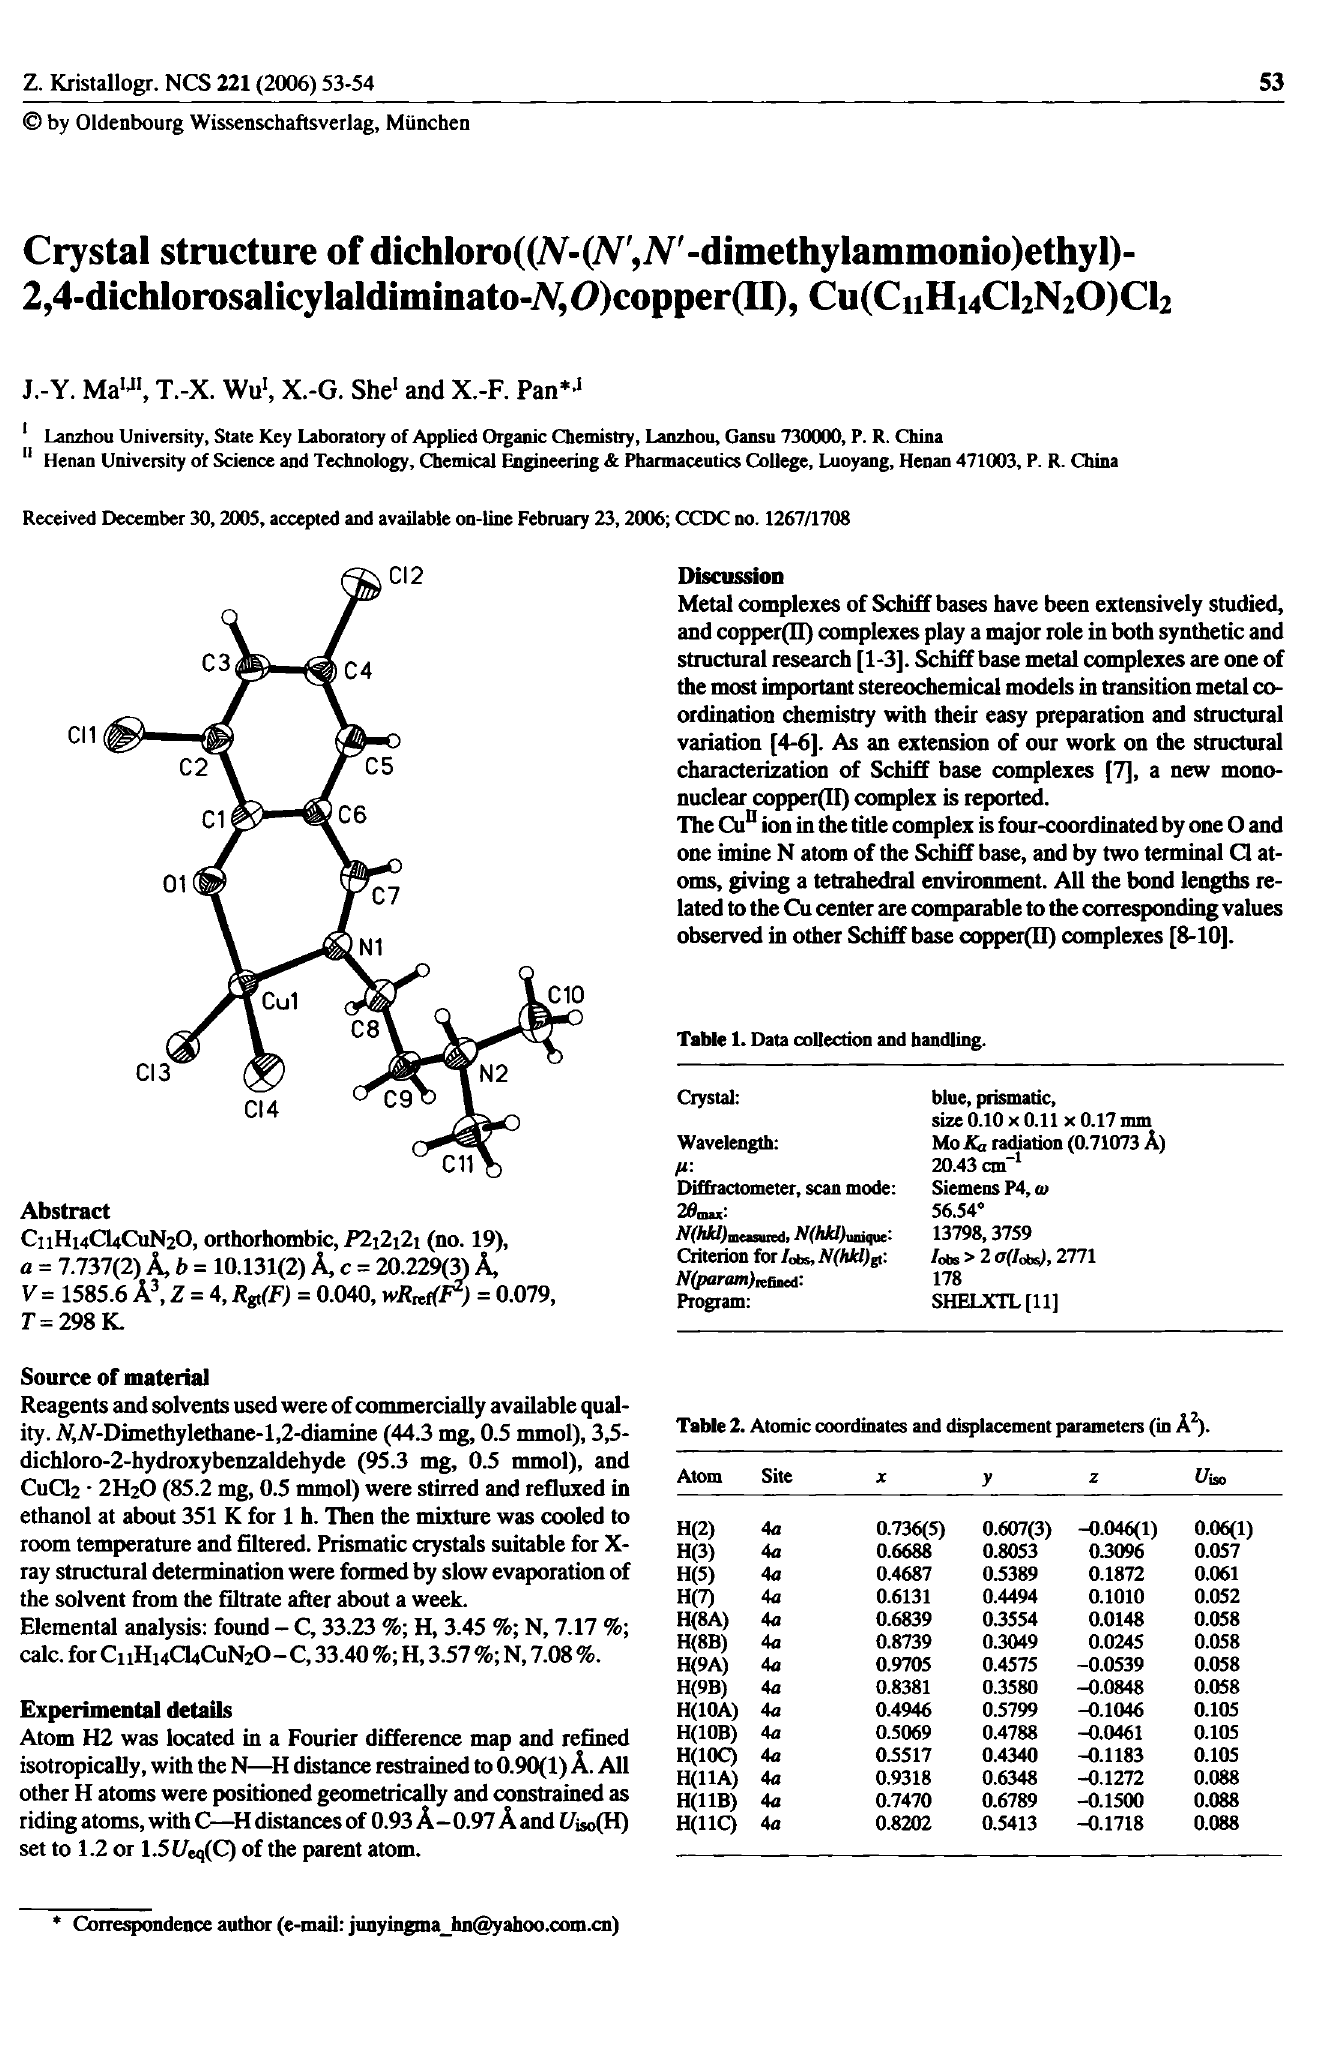
Table 2. Atomic coordinates and displacement parameters (in A 2